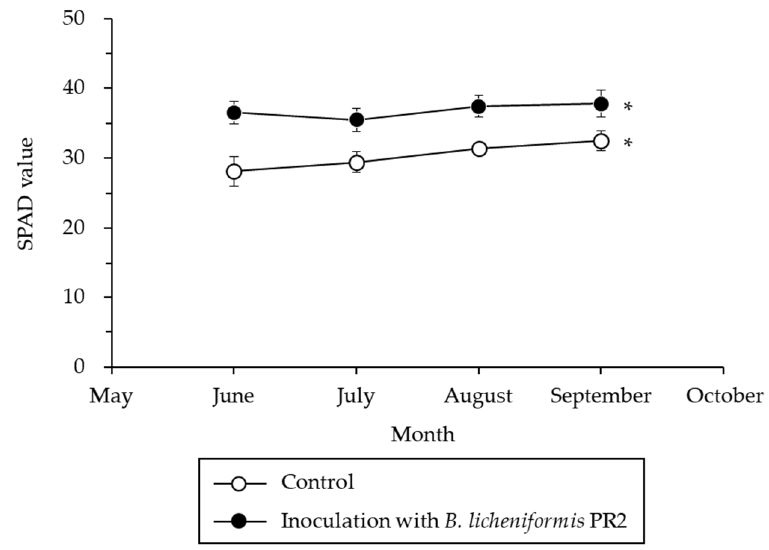
Figure 6. Average chlorophyll contents in jujube control trees and trees inoculated with B. licheniformis PR2 in 2019 and 2020. * indicates a significant difference at p < 0.05.